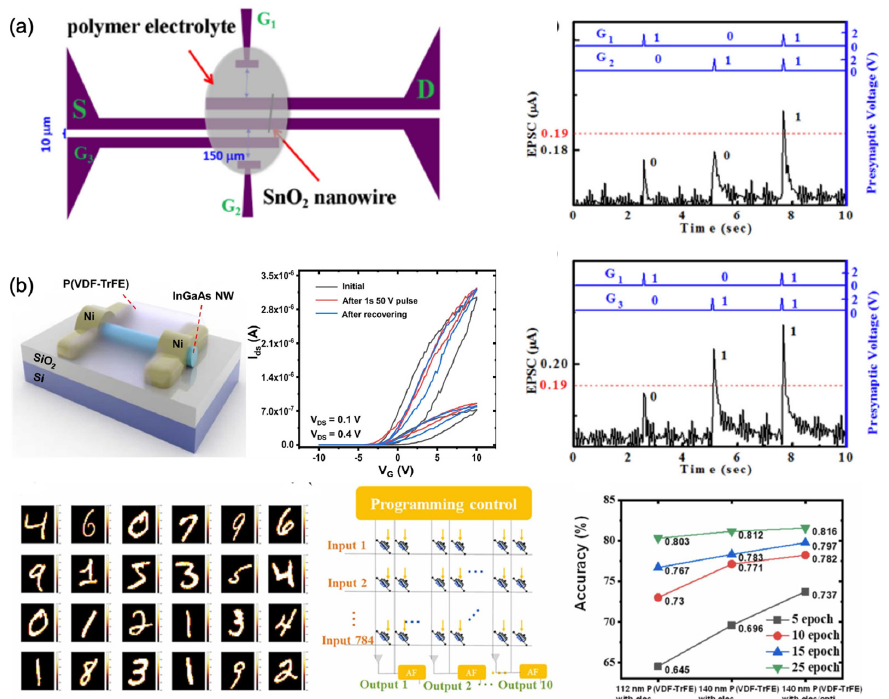
Figure 9. ( a ) Schematic diagram of a multi-gate SnO 2 transistor covered with polymer-electrolyte and its application in logic gate [57] Reprinted/adapted with permission from Ref. [57] Zou,